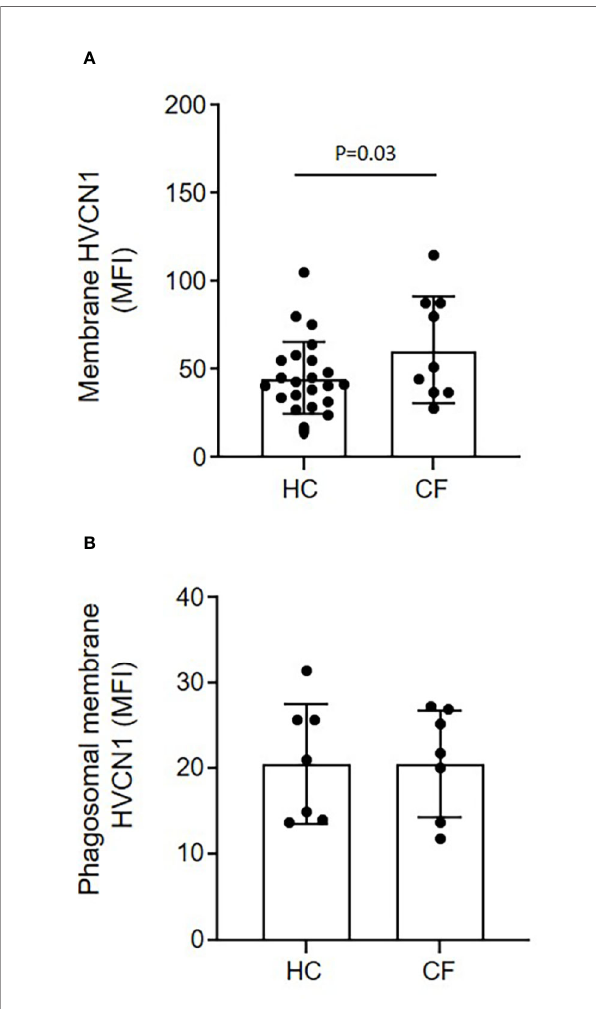
FIGURE 5 | Equal expression of the H + proton channel HVCN1 on phagocytic membranes of neutrophils of HC and PWCF. Neutrophil membrane levels of HVCN1 were quanti fi ed by fl ow cytometry and expressed as mean fl uorescence intensity (MFI). (A) CF neutrophils demonstrated increased plasma membrane HCVN1 expression compared to HC samples (n = 23 and n = 9, respectively, paired t test). (B) Phagosomes were isolated following 8 min phagocytosis of IgG opsonized latex particles. CF phagosomes demonstrated equal levels of HVCN1 compared to HC (n = 7 per group, paired t test, p =